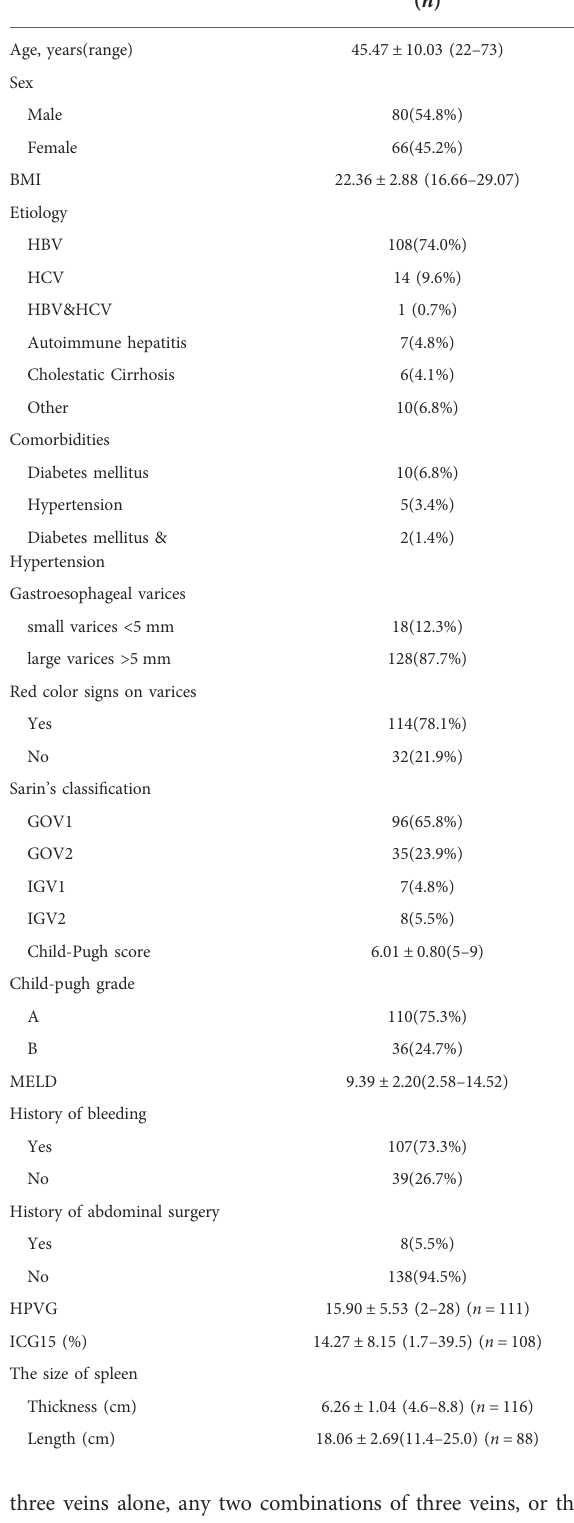
TABLE 1 Patients characteristics ( n =146).